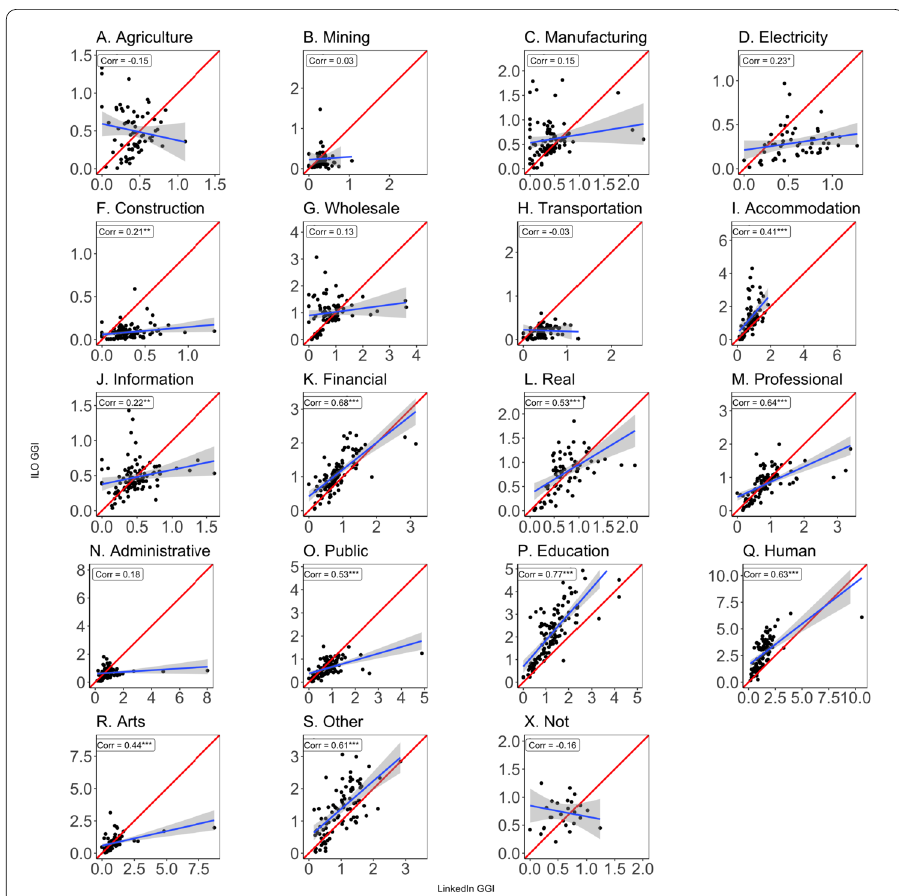
Figure 6 Scatter plot of industry-specific LinkedIn GGI ( x -axis) and ILO GGI ( y -axis). Note: Full industry names are: A. Agriculture; forestry and fishing; B. Mining and quarrying; C. Manufacturing; D. Electricity; gas, steam and air conditioning supply; “F. Construction; G. Wholesale and retail trade; repair of motor vehicles and